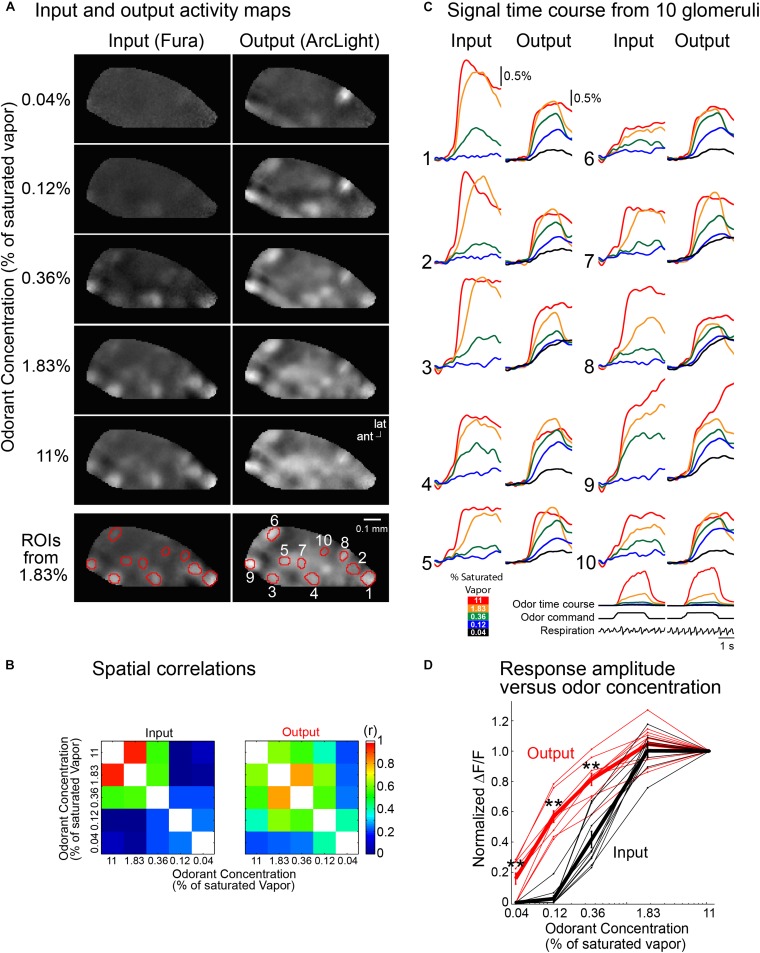
Comparing the input and output from ten glomeruli in the same bulb using Fura dextran (input) and the GEVI ArcLight (output). (A) Frame subtraction activity maps at five methyl valerate concentrations for input (left) and output (right). The output maps are much more similar to each other in comparison with the input maps. To illustrate the similarity of the output maps, each output response map was scaled so that all five maps had the same maximum and minimum brightness values. The input map for 11% saturated odor was scaled to have the same maximum and minimum brightness values as the five output maps. The input maps for the lower odorant concentrations were first scaled by the same scaling factors that were used for the output maps and are shown using the same maximum and minimum brightness scale as the 11% odorant map. The input map’s signals declined much more rapidly with decreasing odorant concentration. The selected glomeruli used for the time course results in panel (C) are indicated in the bottom panel (ROIs from 1.83%). (B) Spatial correlation of the 1.83% frame subtraction map with the four other odor concentrations. (C) Input and output traces of fluorescence vs. time for the ten glomeruli. The input signals decrease more dramatically than those of the output. The traces are low-pass filtered at 1 Hz. Odor time course (measured simultaneously with a photo-ionization detector), odor command pulse and respiration are shown under glomerulus 10. (D) Normalized peak fluorescence change vs. odorant concentration for the glomeruli in panel (C) (black, input; red, output). The activity maps in panel (A) and the traces in panel (C) are the average of 4–20 individual trials aligned to the first sniff following odor onset; ∗∗p < 0.001. ant, anterior; lat, lateral. Modified from Storace and Cohen (2017).